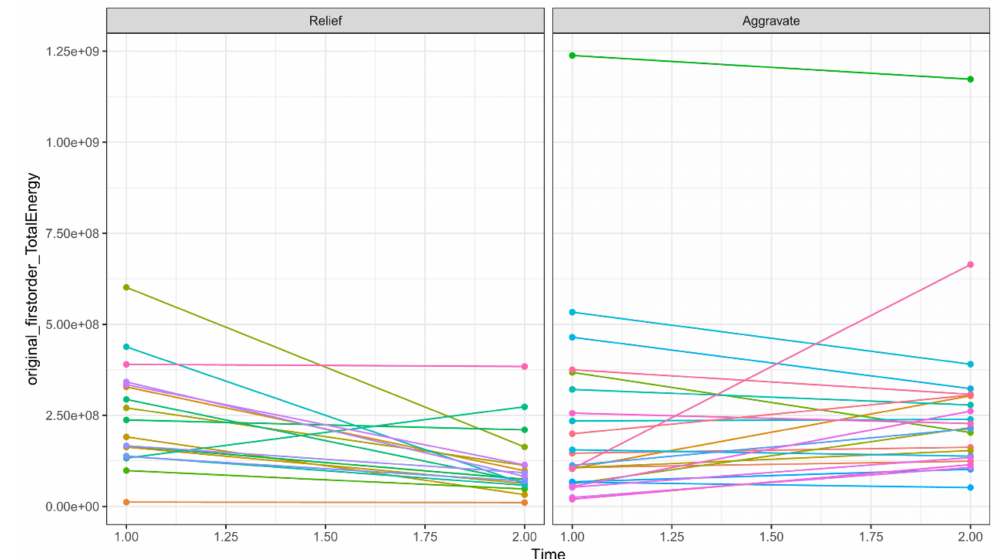
Figure 6. The differences in wavelet_LLH_firstorder_Variance between relief and aggravate groups.